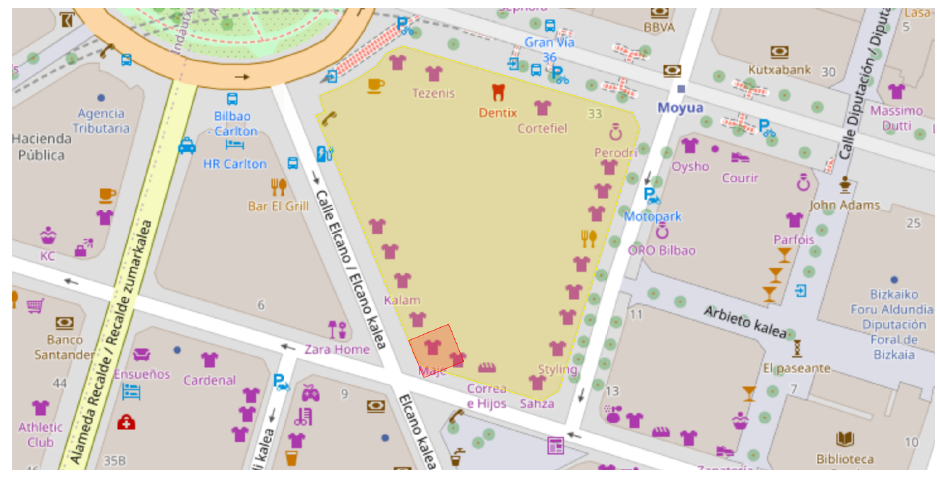
Figure 25. Convex hull After that, the previously calculated limits are again subtracted from the surface (see Figure 26).